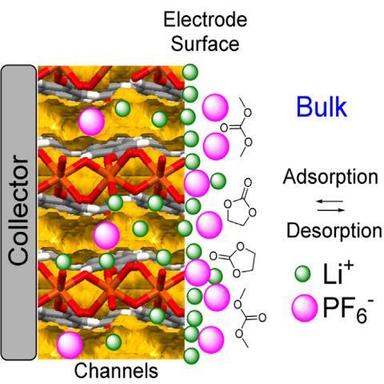
The adsorption and desorption of charge in the Fe-BDC.